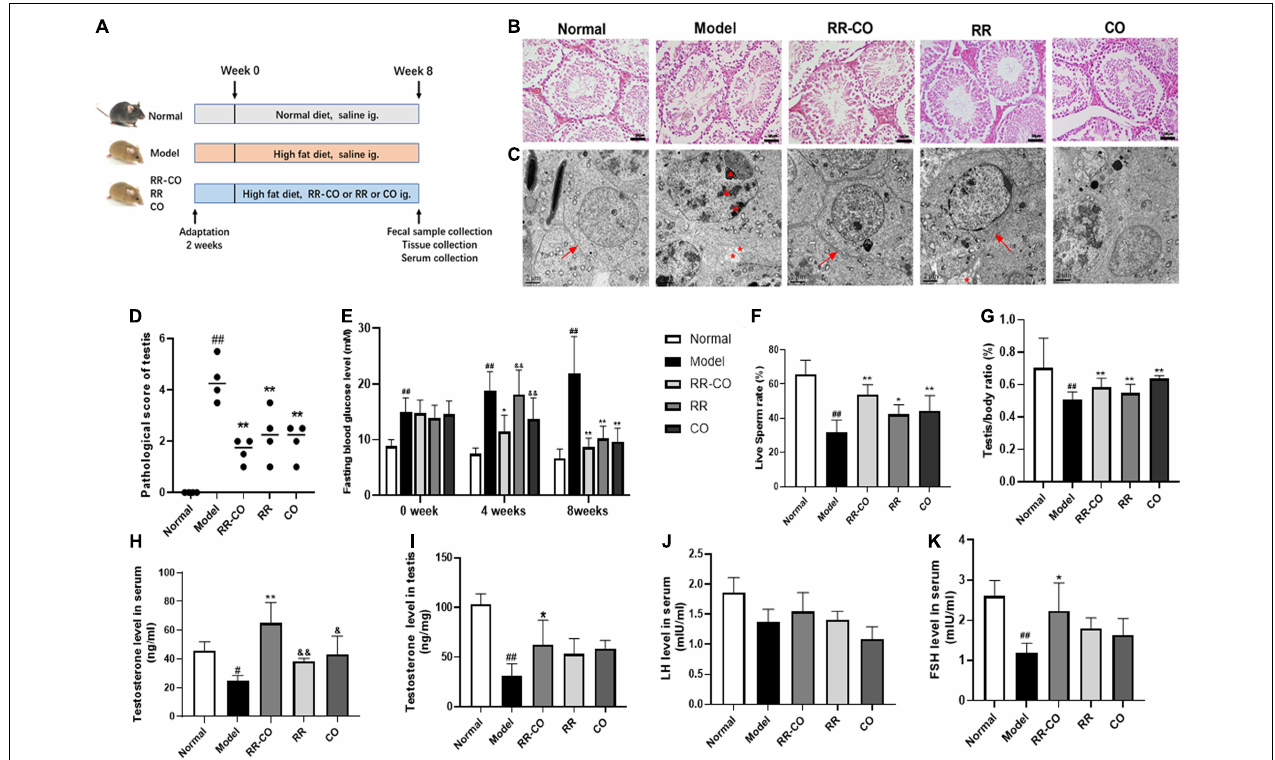
FIGURE 1 | The effects of RR-CO on testicular morphological injury, fasting blood glucose, sperm motility, and testosterone level in DM mice. (A) Flow chart of animal study design. (B) H&E staining of mice testicular tissues. Scale bar, 50 µ m. (C) Transmission electron microscopic observation of testicular ultrastructure of mice ( blacktriangle , nuclear chromatin; *, cytoplasmic vacuolation; → , tight junctions). Scale bar, 2 µ m. (D) A chart showing testicular lesion scores vs. model group. (E) FBG levels over the 8-week experiment. (F) Live sperm rate. (G) Testis/body weight ratio. (H) Serum testosterone level. (I) Testicular testosterone level. (J) Serum LH level. (K) Serum FSH level. Data are expressed as mean ± SD. # P < 0.05; ## P < 0.01 vs. normal group. * P < 0.05; ** P < 0.01 vs. model group. & P < 0.05; && P < 0.01 vs. RR-CO